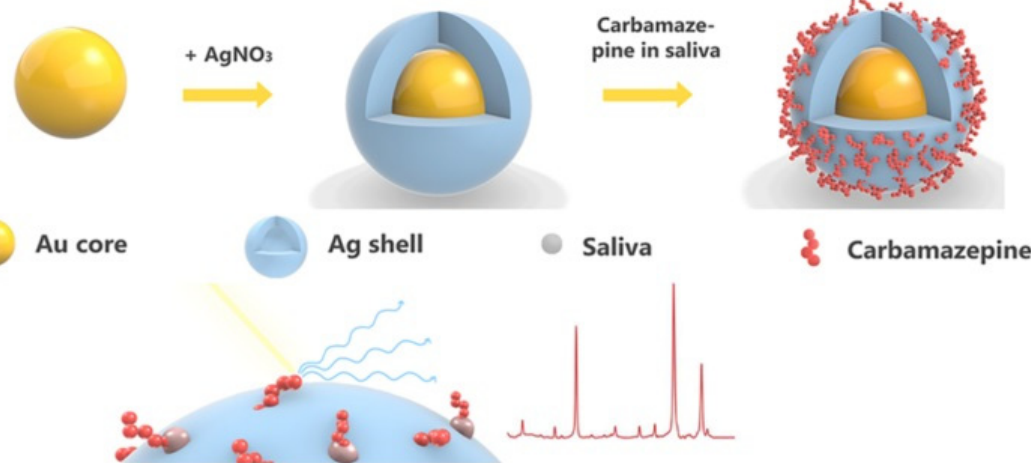
Figure 9. The schematic illustration of the synthesis of Au@Ag nanoparticles and the SERS detection of CBZ in saliva. Reproduced with permission from [69]. Copyright 2021 Optical Society of America.